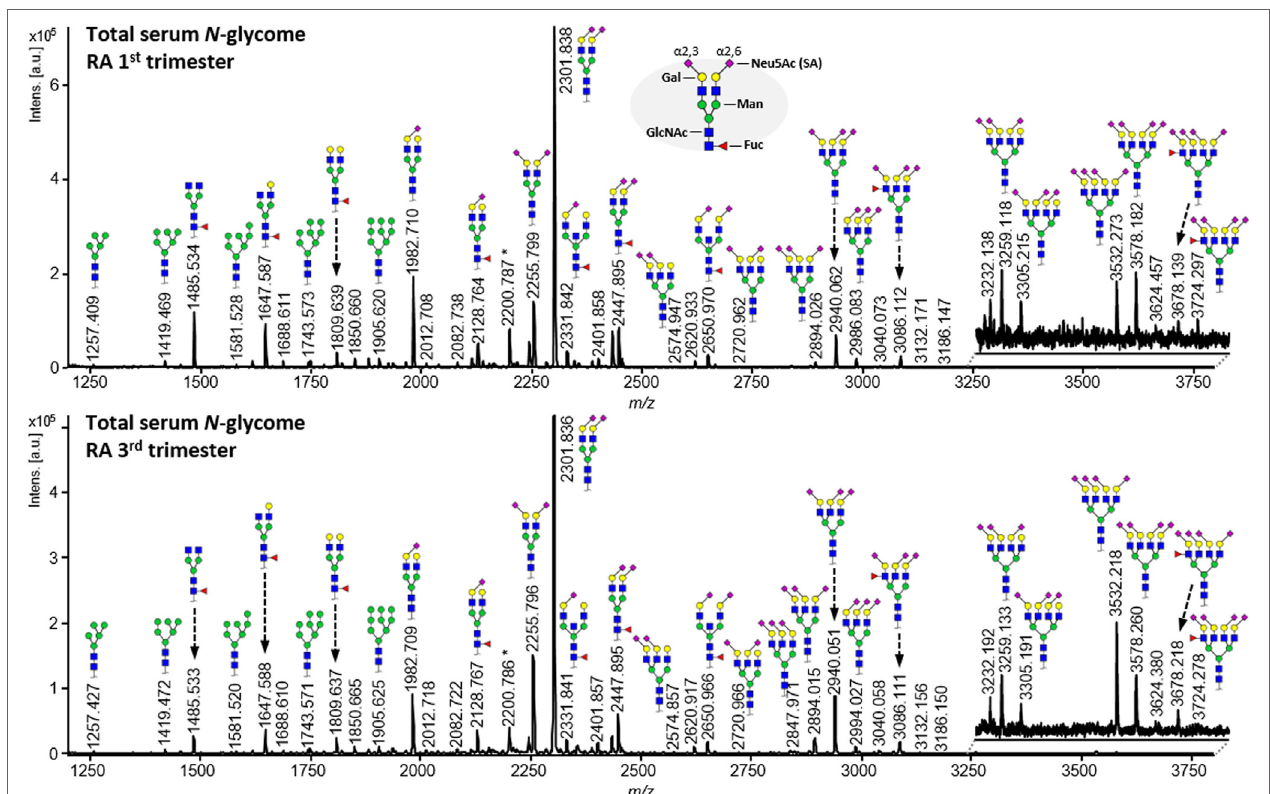
FigUre 2 | Comparison of matrix-assisted laser desorption/ionization time-of-flight mass spectrometry spectra obtained from released N -glycans from serum proteins after linkage-specific sialic acid esterification and HILIC enrichment. The shown spectra are derived from an individual with rheumatoid arthritis who has been diagnosed with ACPA and RF, and has been classified as a responder by the EULAR response criteria. Notable differences between the first trimester ( top ) and third trimester ( bottom ) spectra include galactosylation (e.g., between m / z 1,485.5, 1,647.6, and 1,809.6), antennarity (e.g., m / z 2,940.1 vs. 2,301.8), α 2,3-linked sialylation (e.g., m / z 2,255.8 vs. 2,301.8), and α 2,6-linked sialylation (e.g., m / z 1,982.7 vs.